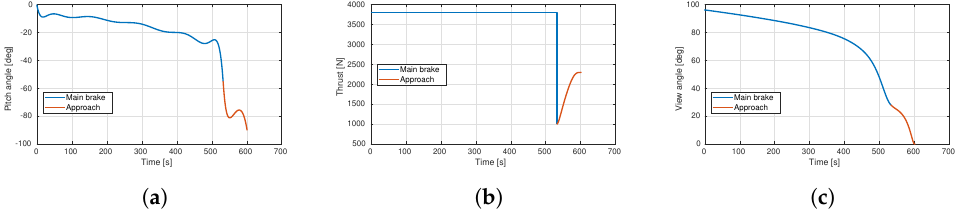
Figure 8. Thrust profile (orientation and magnitude) and pitch angle profile for the nominal landing trajectory (powered descent and final approach only). Same testing trajectory as [1]. ( a ) Thrust angle. ( b ) Thrust magnitude. ( c ) View angle over landing site.